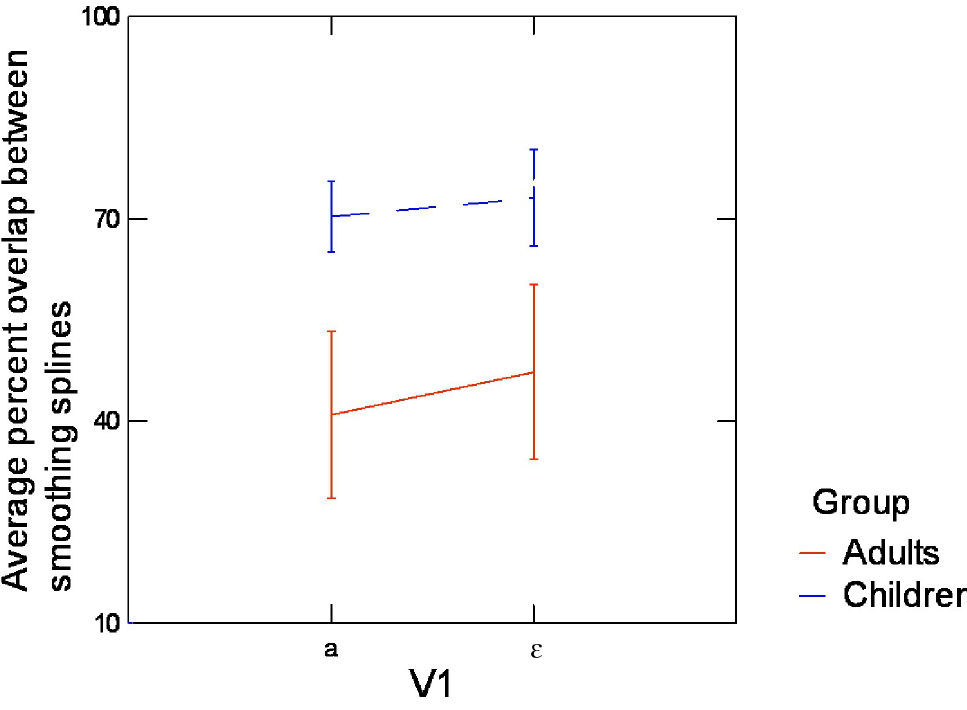
Fig 10. Average overlap across consonantal contexts between the confidence intervals of the average smoothing splines for V 1 in both V 2 contexts, for children and adults. Error bars are standard errors of the mean.